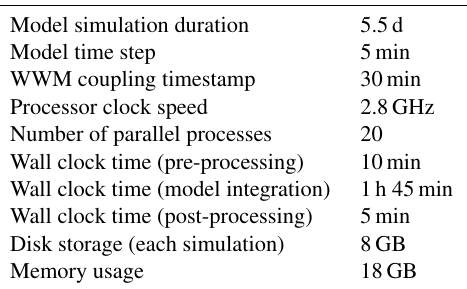
Table 2. Computing environment used during the